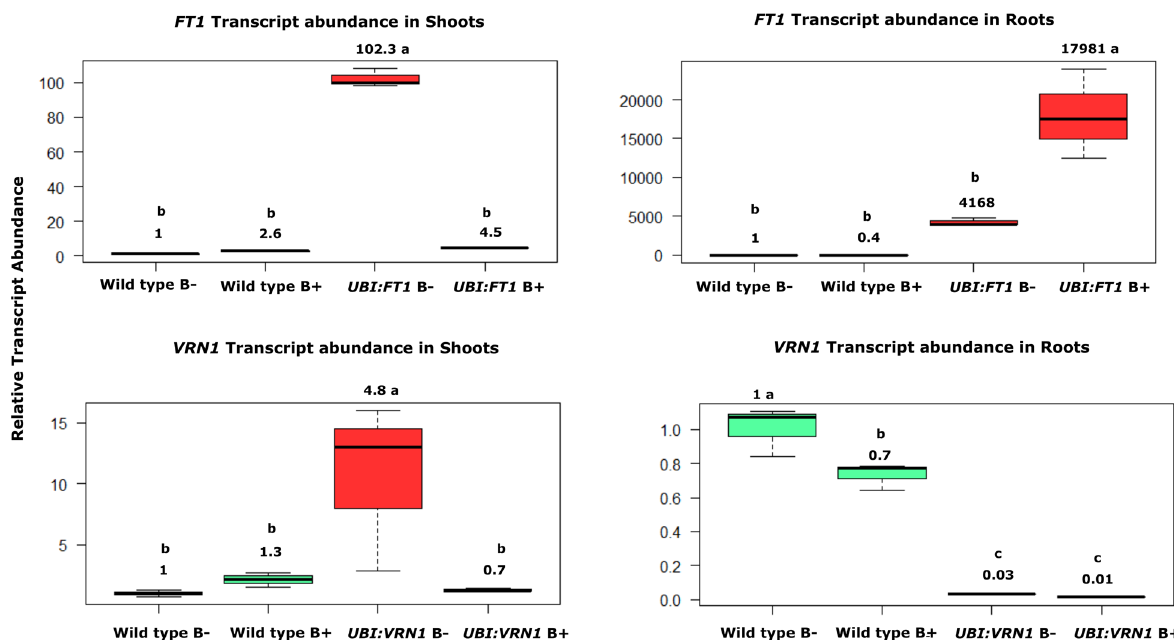
Figure 4. Comparison of relative transcript abundance of flowering genes in shoots and roots of inoculated (B+) and control (B−) wild type Bd21-3 and transgenic lines UBI:FT1 , UBI:VRN1 at 28 dpi. Numbers above the box plots represent fold change. Different alphabet above each box represent significance according to Tukey’s test ( p <